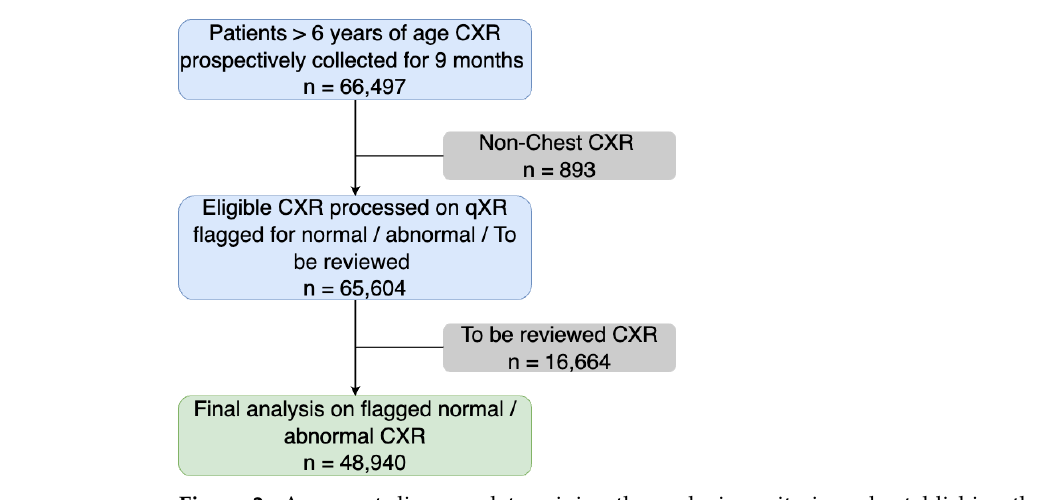
Figure 2. A consort diagram determining the exclusion criteria and establishing the final study population.